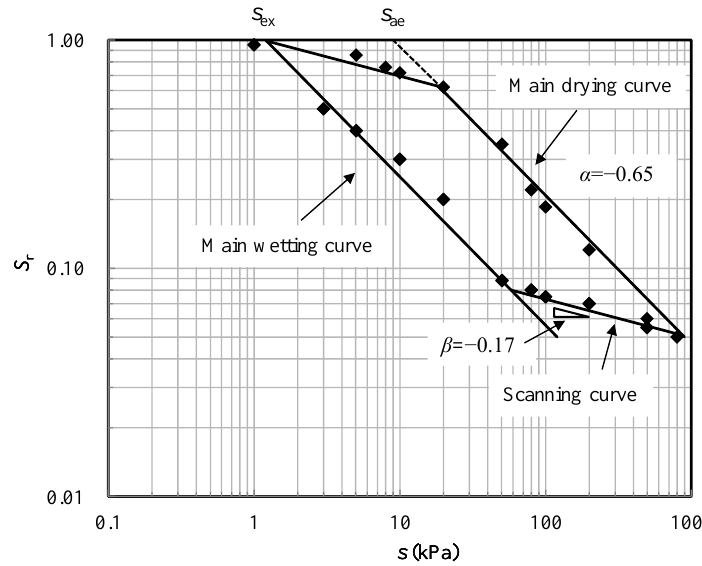
Figure 2. SWCC of sand–kaolin mixture with a void ratio 0.42.